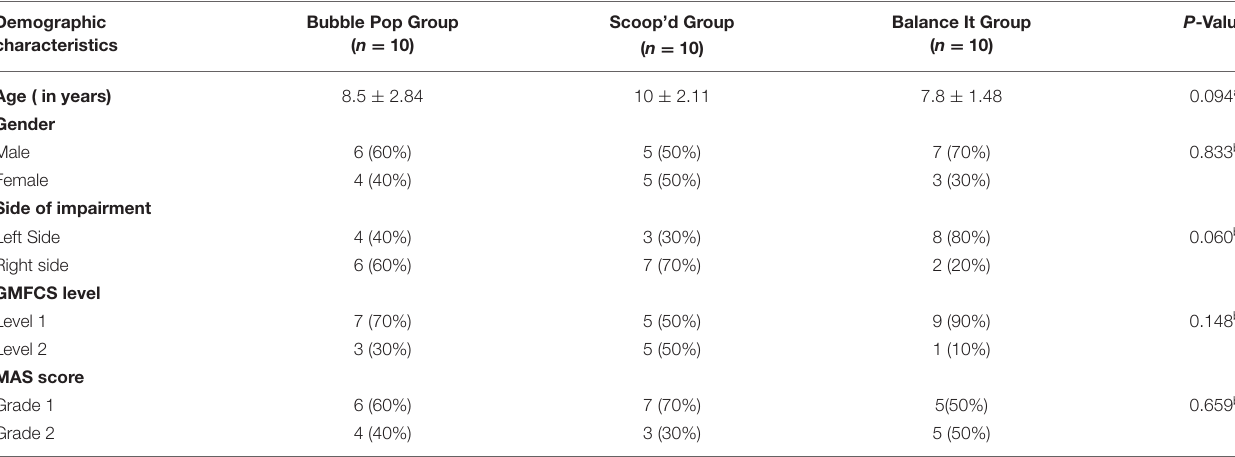
TABLE 1 | Demographic and baseline characteristics of the study